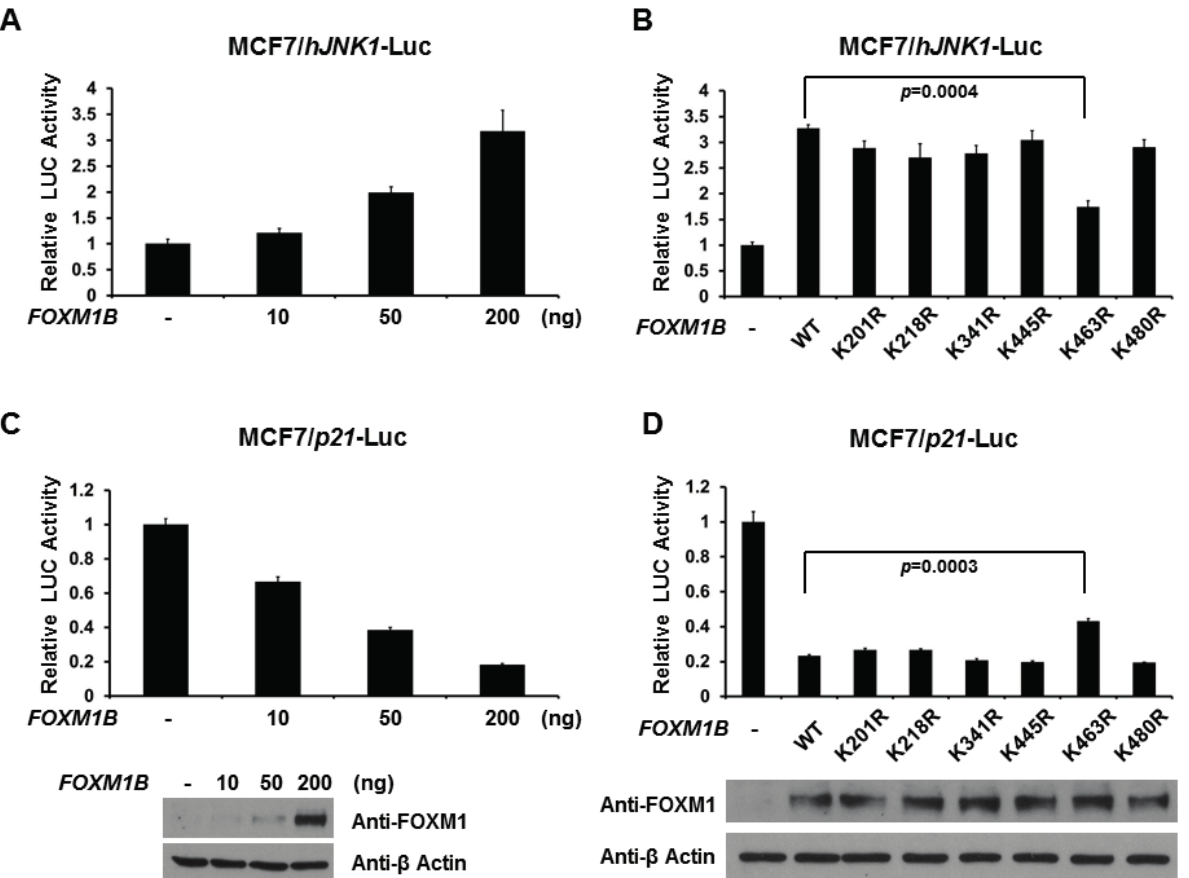
Figure 5. Loss of SUMOylation alters the activities of JNK1 and p21 promoters by FOXM1B. MCF7 cells were transfected, where indicated, with different amounts of FOXM1B expression plasmid and a reporter plasmid with JNK1 promoter ( A ) or p21 promoter ( C ); MCF7 cells were transfected, where indicated, with WT or mutant FOXM1B expression plasmid and a reporter plasmid with JNK1 promoter ( B ) or p21 promoter ( D ). Luciferase activities were measured 48 h after transfection and normalized with Renilla activity. Relative LUC activity (fold activation) was calculated and plotted. The expression levels of FOXM1B in MCF7 cells from the reporter assays were validated using anti-FOXM1 immunoblotting. Experiments were performed three times with similar